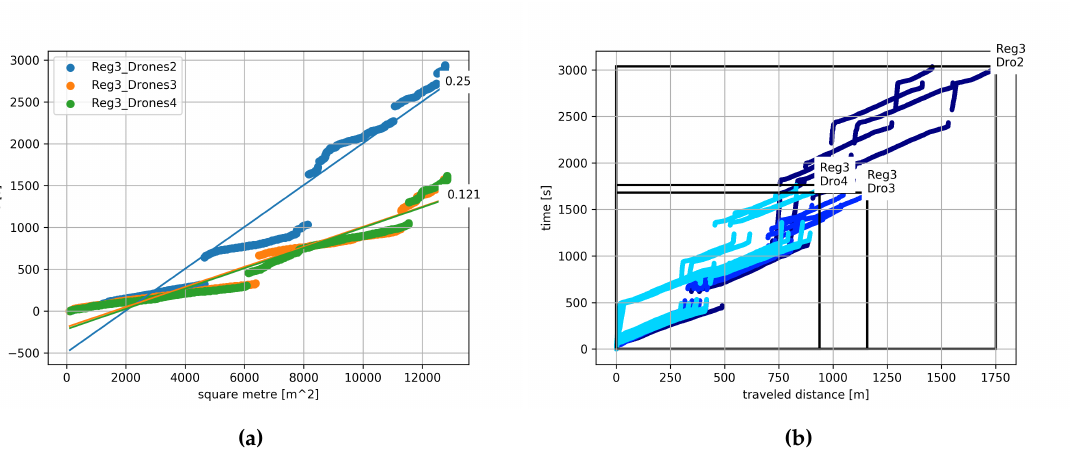
Figure 9. Algorithm scalability with respect to the number of drones. We evaluate a system of 2, 3 and 4 drones. ( a ) Time needed to observe a certain number of square meters. ( b ) Time required for each UAV to travel a certain